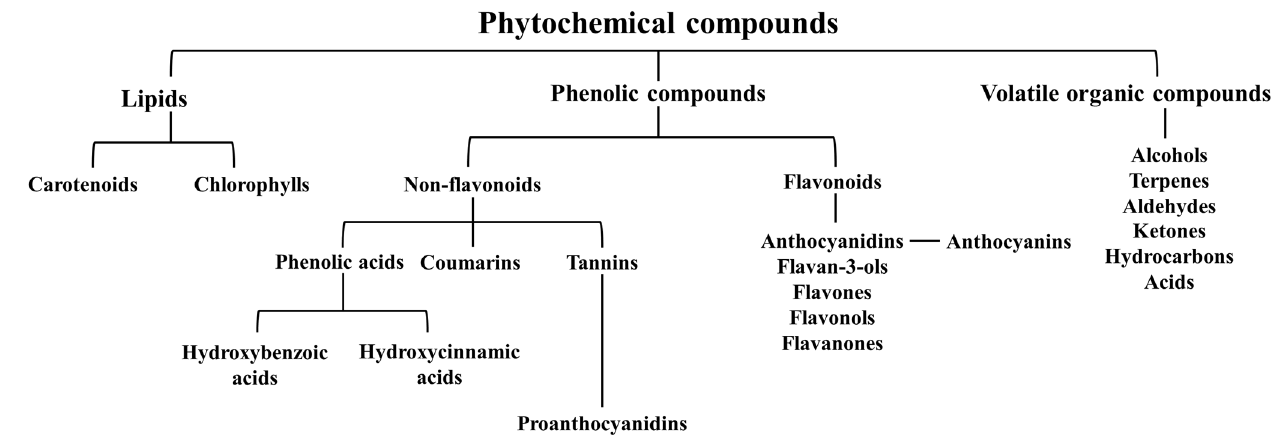
Figure 2. Main phytochemicals found in Juniperus communis L. (adapted from Fátima et al.